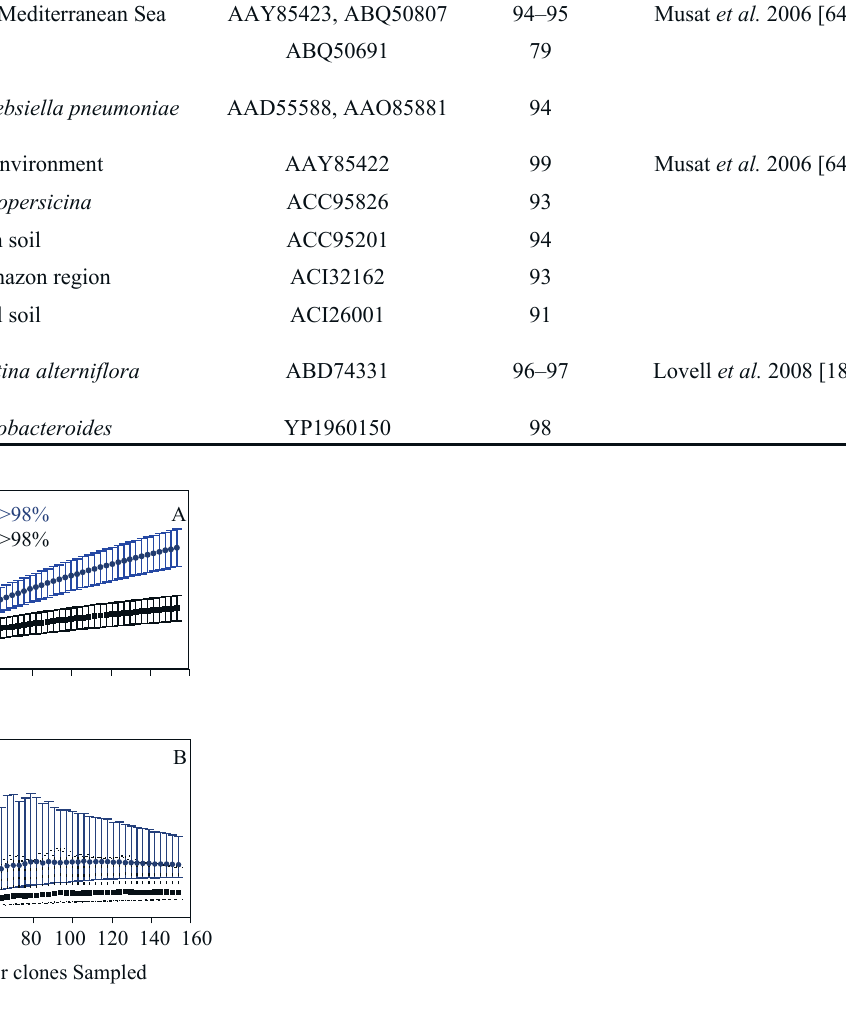
Figure 1. Rarefraction analysis of the nifH gene clones ( A ); and Chao1 index of richness (total number of OTUs in a community) estimated as a function of sample size ( B ). Curves are averaged over 50 simulations using the computer program EstimateS. All error bars are